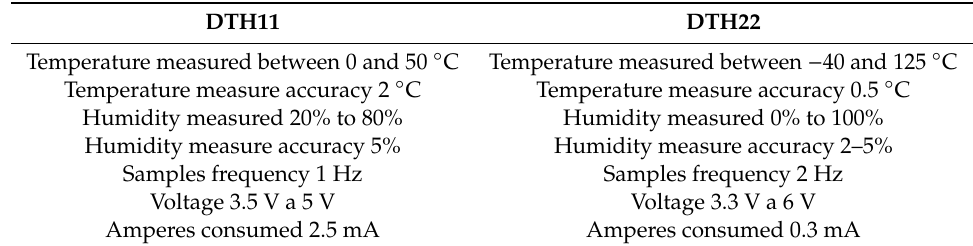
Table 12. Comparison of temperature sensors used in smart city projects.